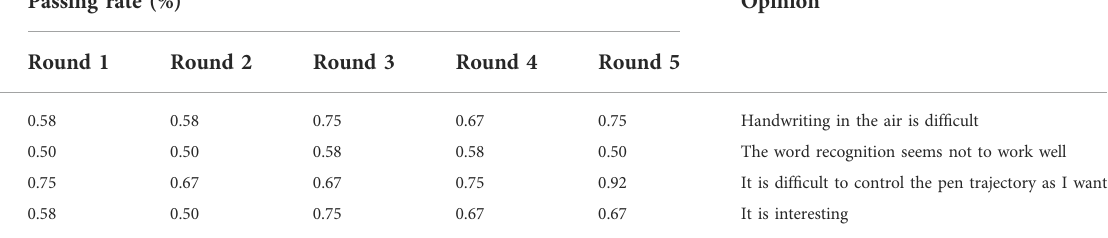
TABLE 3 Passing rates and opinions of